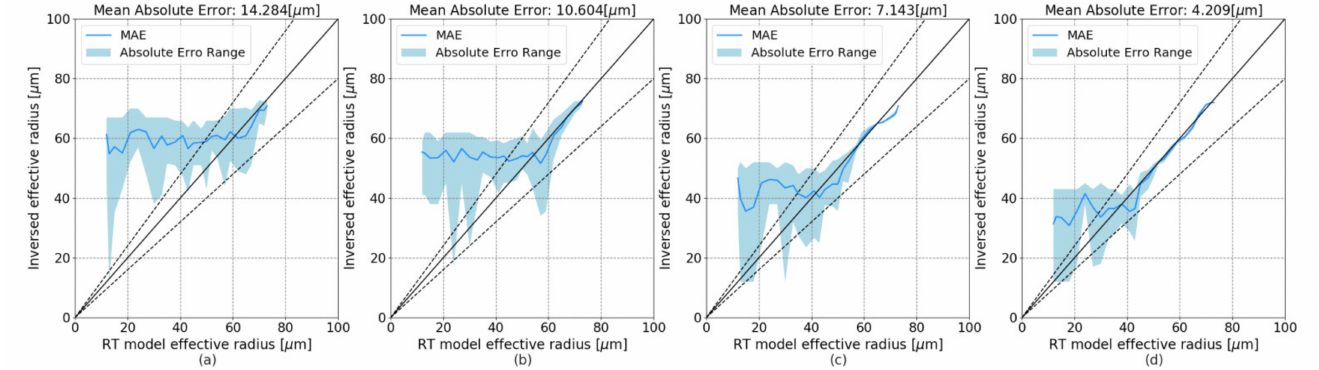
Figure 6. The single-channel D me inversion results. ( a ) 325.15 ± 9.5 GHz channel; ( b ) 448.0 ± 3.0 GHz channel; ( c ) 664.0 ± 4.2 GHz channel; ( d ) 874.4 ± 6.0 GHz channel.